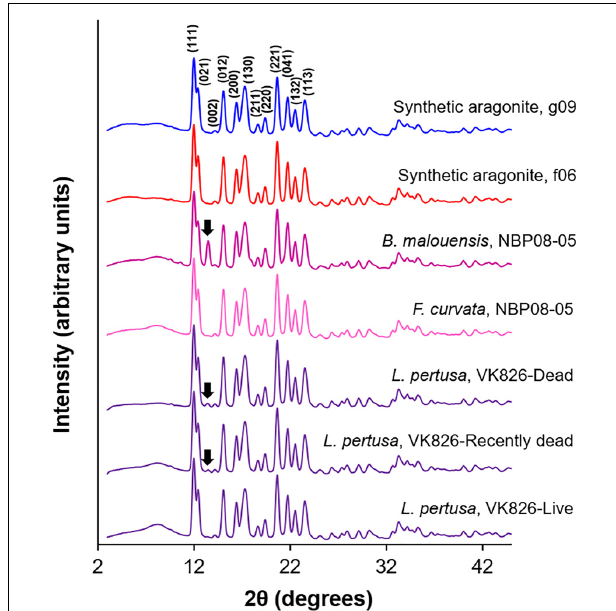
FIGURE 1 | Representative XRD patterns of deep-sea corals and synthetic aragonites using Mo K α radiation ( λ = 0.709300 Å). Miller indices are labeled on the g09 synthetic aragonite pattern and all patterns are normalized to the (111) peak heights. Calcite contributions are highlighted with black arrows on certain